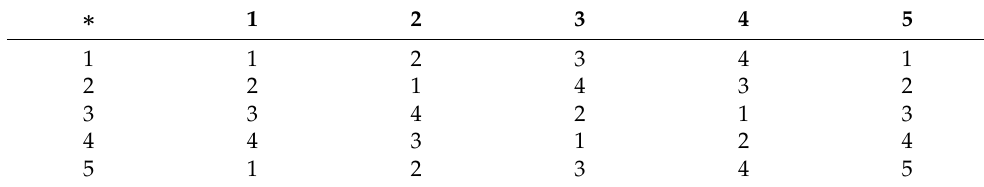
Table 11. A separative T2CA-groupoid of Example